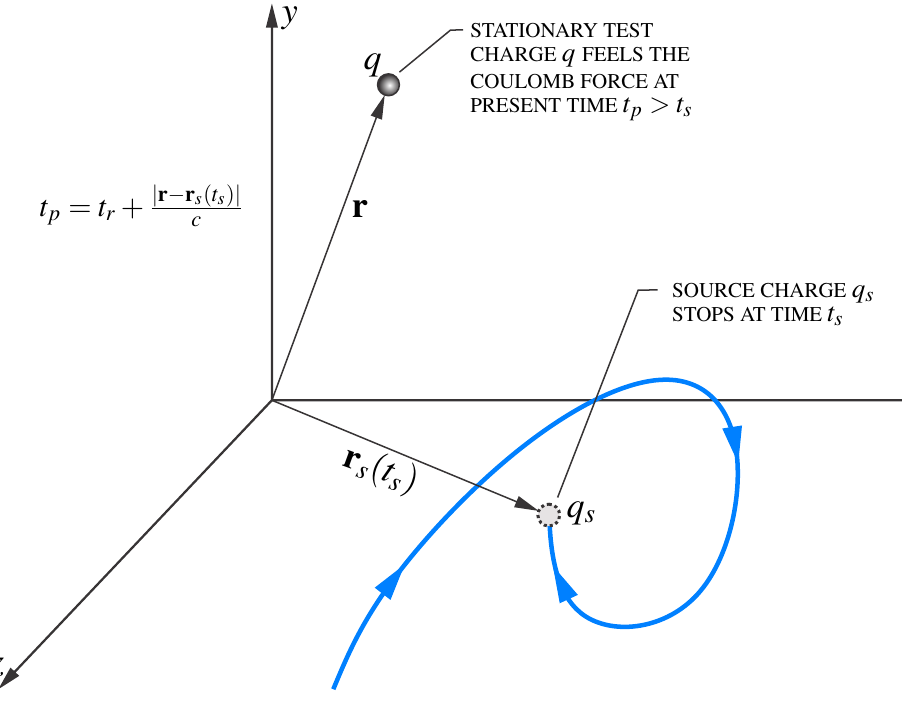
Figure 2. Source charge q s is moving along arbitrary trajectory r s ( t ) and stops at time t s . Because q s stops moving at past time t s , at present time t p , the stationary test charge q experiences electrostatic Coulomb